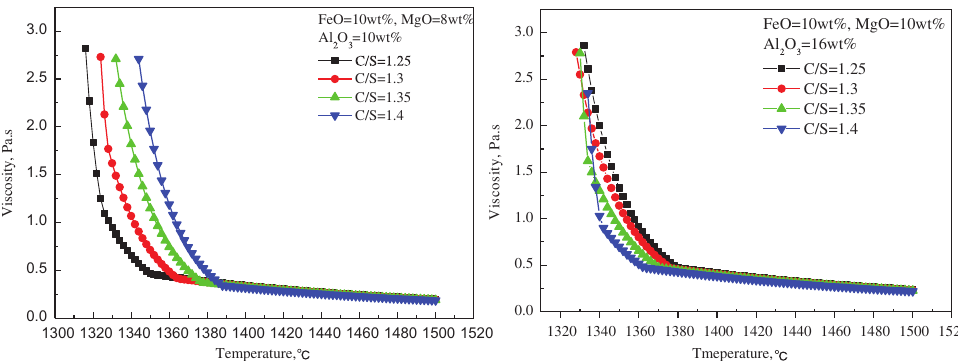
Figure 6: Effect of the slag basicity from 1.25 to 1.4 on the slag viscosity. (a. Al 2 O 3 = 10 wt%, b. Al 2 O 3 = 16 wt%).